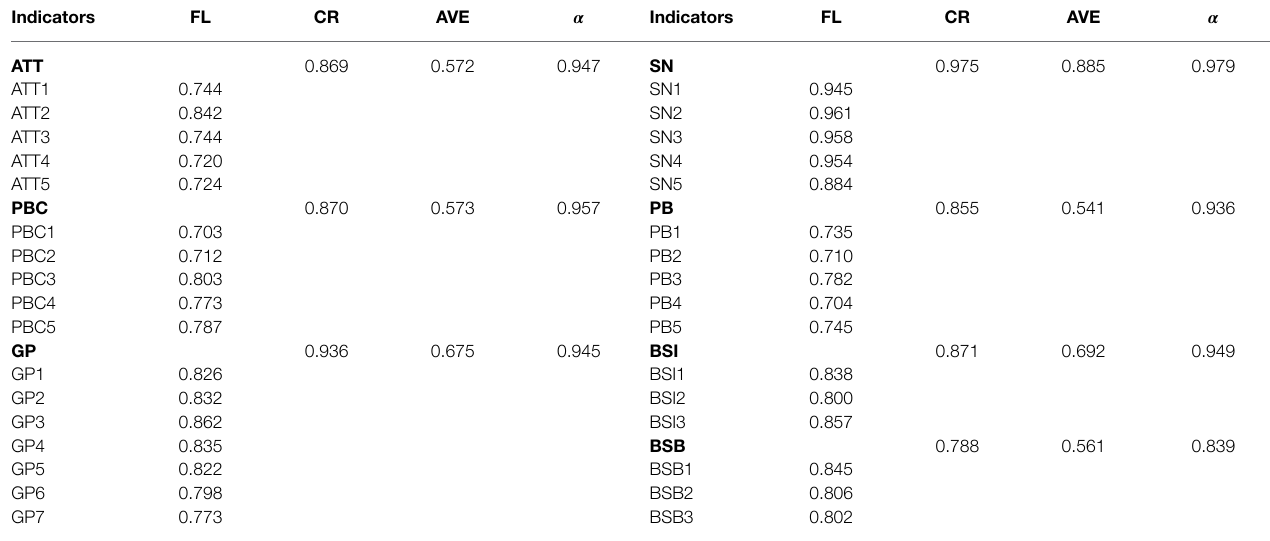
TABLE 3 | Descriptive statistics and the output of the measurement model. Indicators